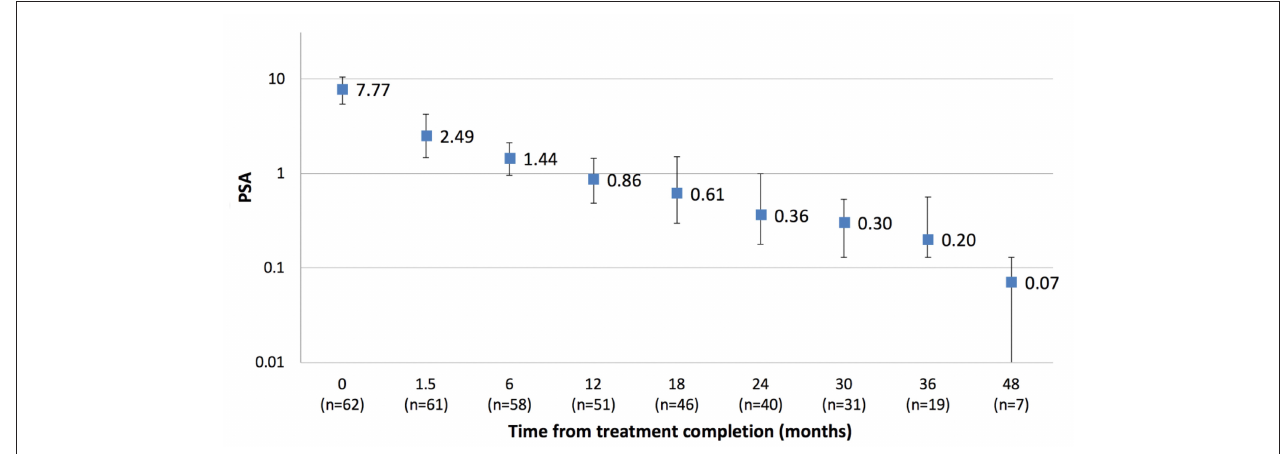
FIGURE 3 | Median PSA response (with interquartile range) in cohort treated without ADT ( n = 62).